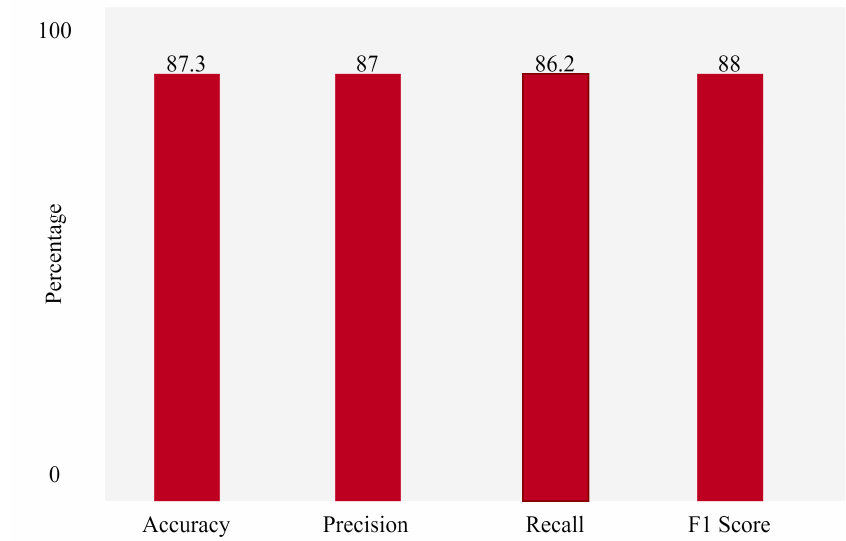
Figure 11. Evaluation of ENN on IoR without k-Means Clustering.